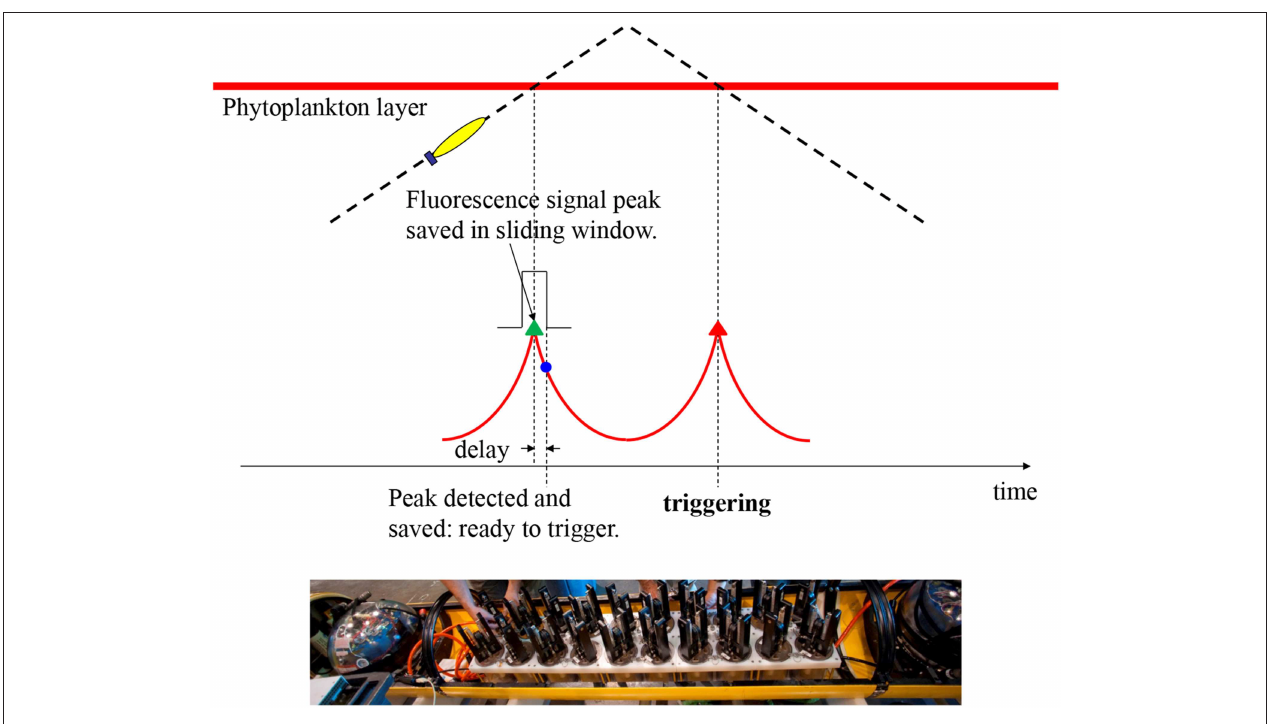
FIGURE 1 | Illustration of the AUV algorithm for capturing peak samples in a phytoplankton patch. On the AUV’s yo-yo trajectory through a phytoplankton layer, the vehicle detects the peak chlorophyll fluorescence (with delay) on the first crossing, and saves the peak signal level. On the second crossing, the AUV triggers sampling at the saved peak fluorescence level with no delay. The bottom photo (courtesy of Todd Walsh) shows 20 “gulper” samplers installed in the midsection of a Dorado-class